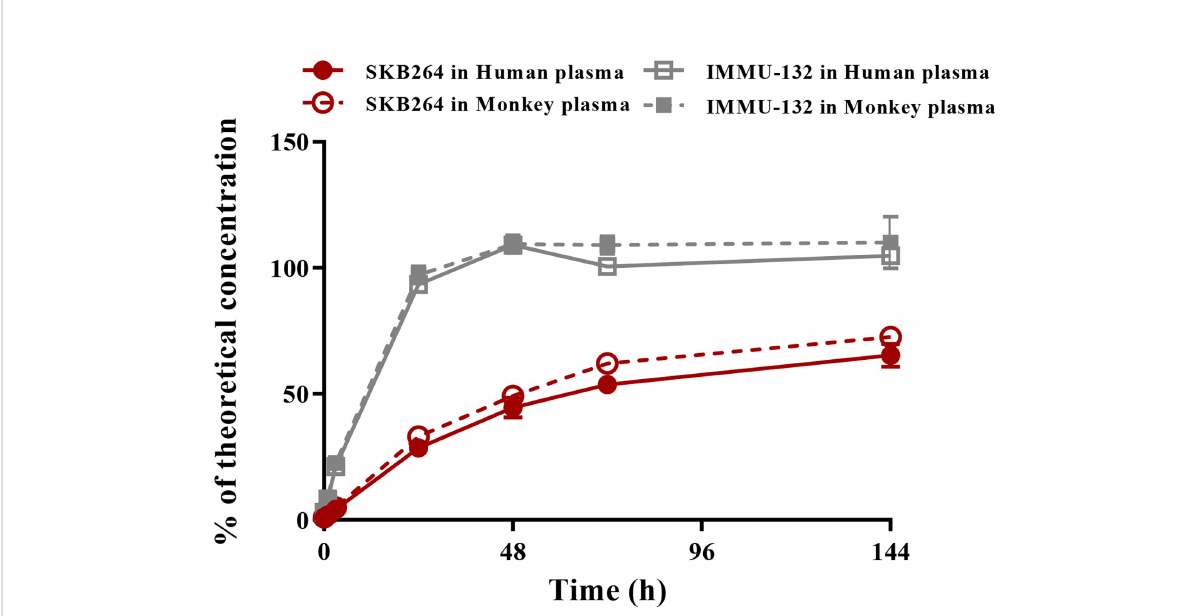
FIGURE 8 Percent of free payload in total available payload during the incubation of SKB264 or IMMU-132 with plasma of monkey and